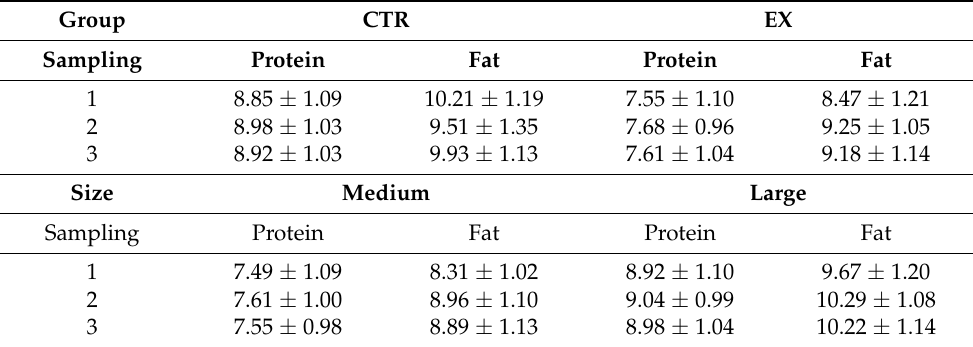
Table 4. Milk chemical composition (% as fed, mean ± SD) in the two groups along the trial. Group CTR EX Sampling